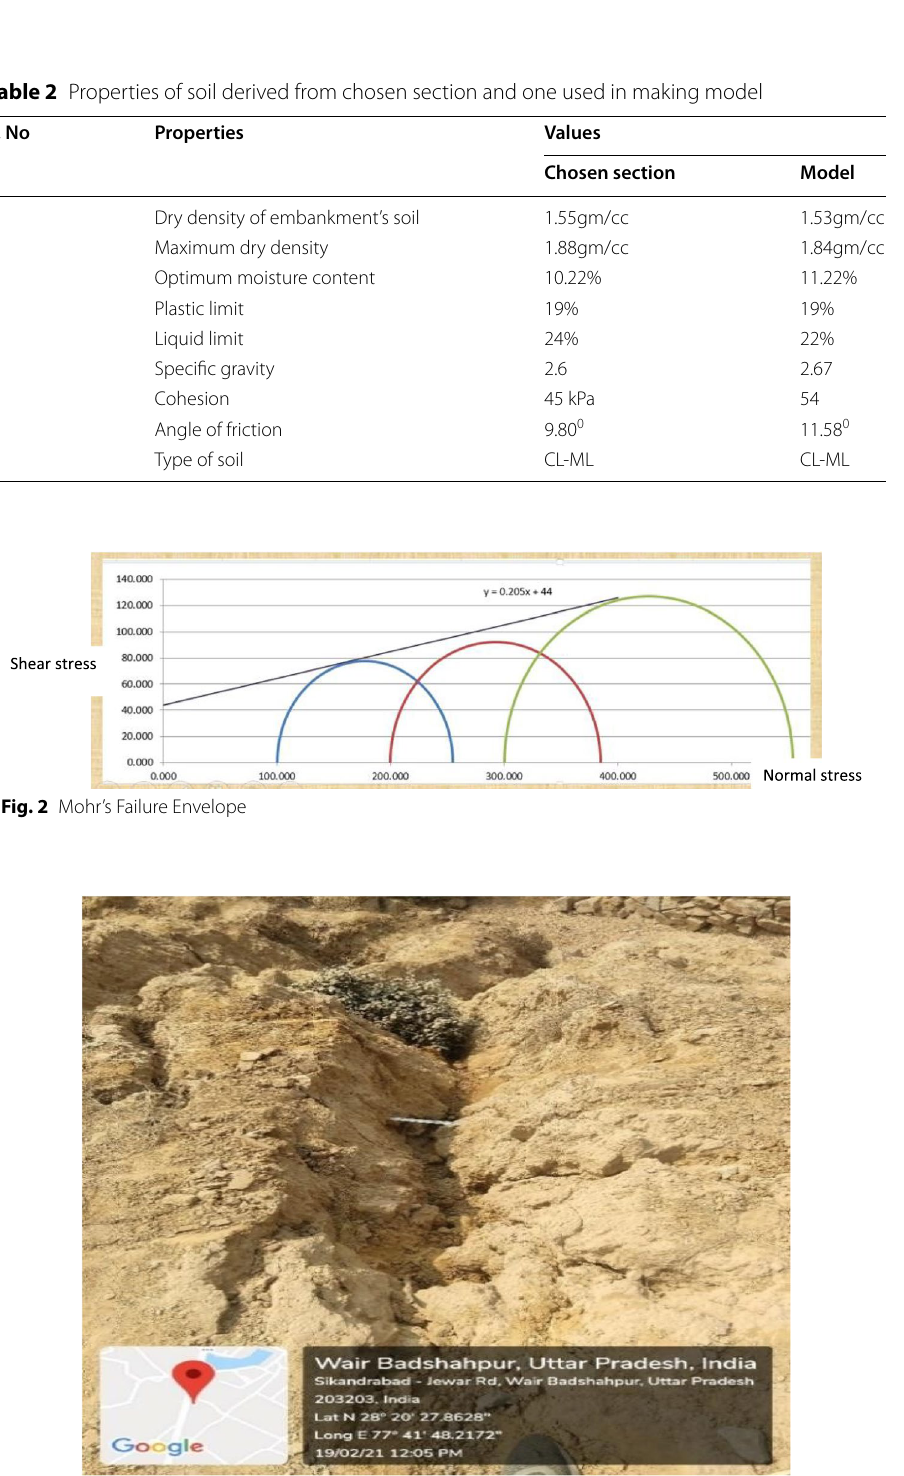
Fig. 3 Studied embankment at Wair, showing effect of gullying and slope failure no